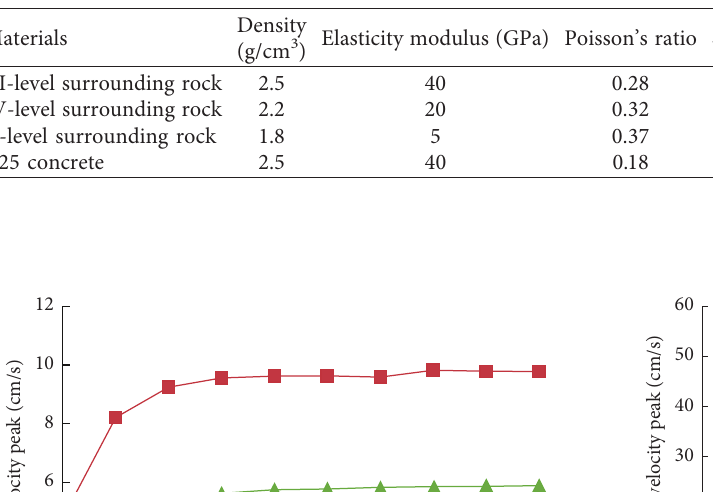
Table 4: Calculation parameters of surrounding rock and concrete.